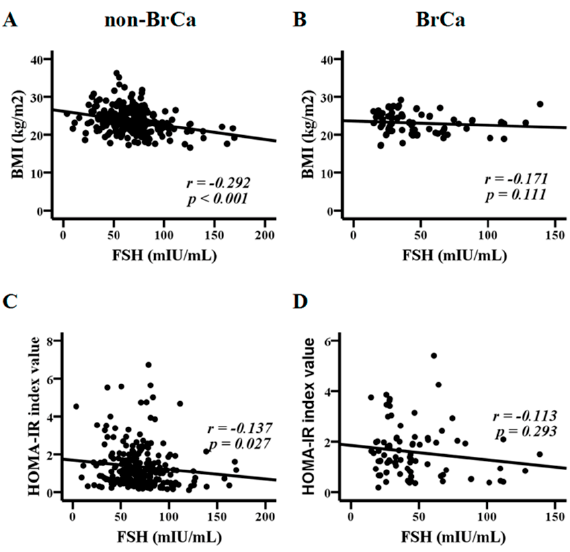
Figure 1. Associations between follicle-stimulating hormone (FSH), body mass index (BMI), and the homeostatic model assessment of insulin resistance (HOMA-IR) index values. FSH was correlated with BMI ( A ) and HOMA-IR ( C ) in the non-breast cancer (non-BrCa) group, but not with BMI ( B ) and HOMA-IR ( D ) in the breast cancer (BrCa) group. The statistical analysis was conducted with Spearman’s rank